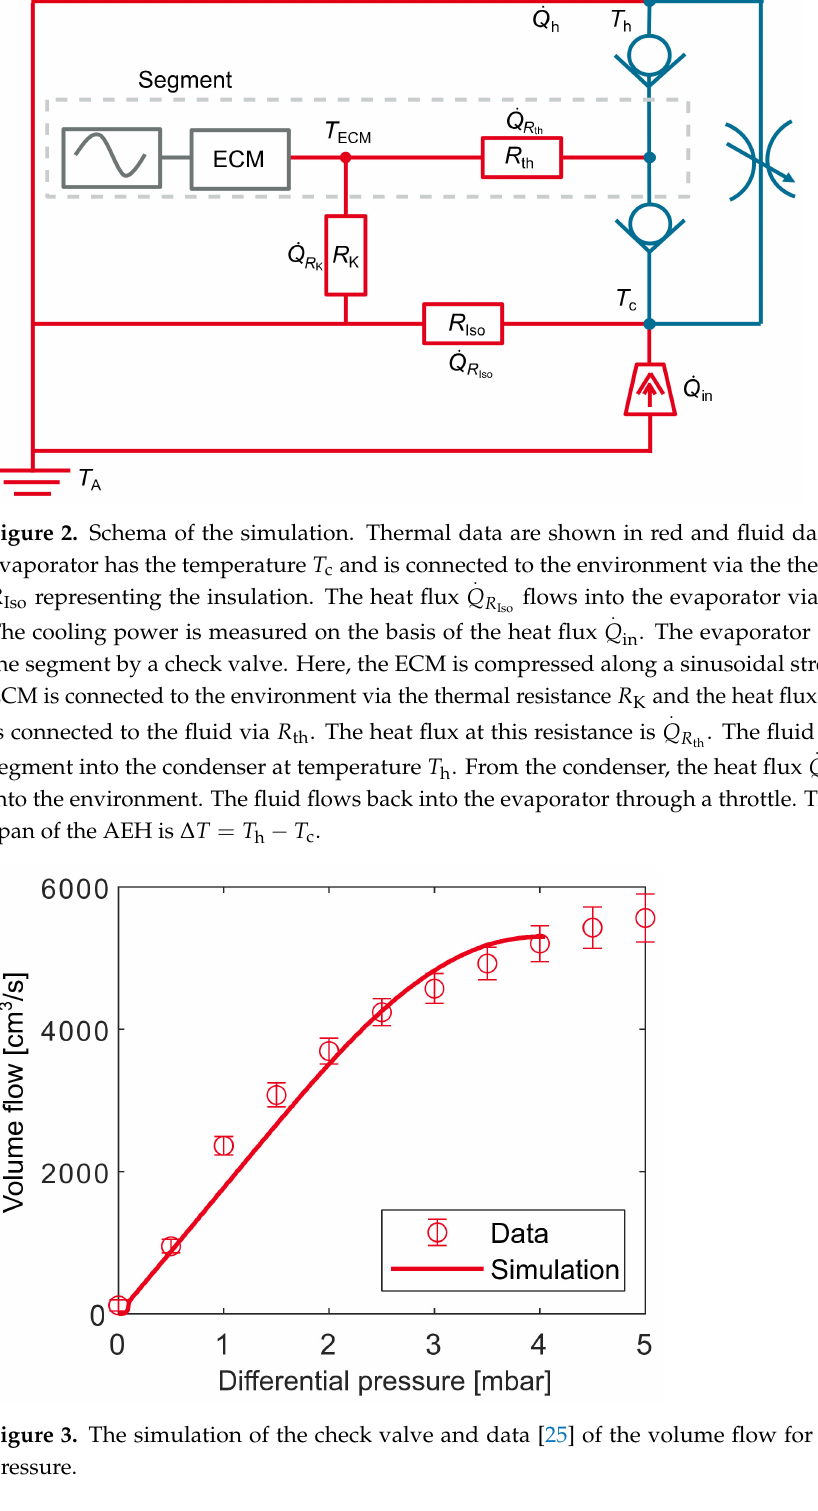
Figure 3. The simulation of the check valve and data [25] of the volume flow for the differential